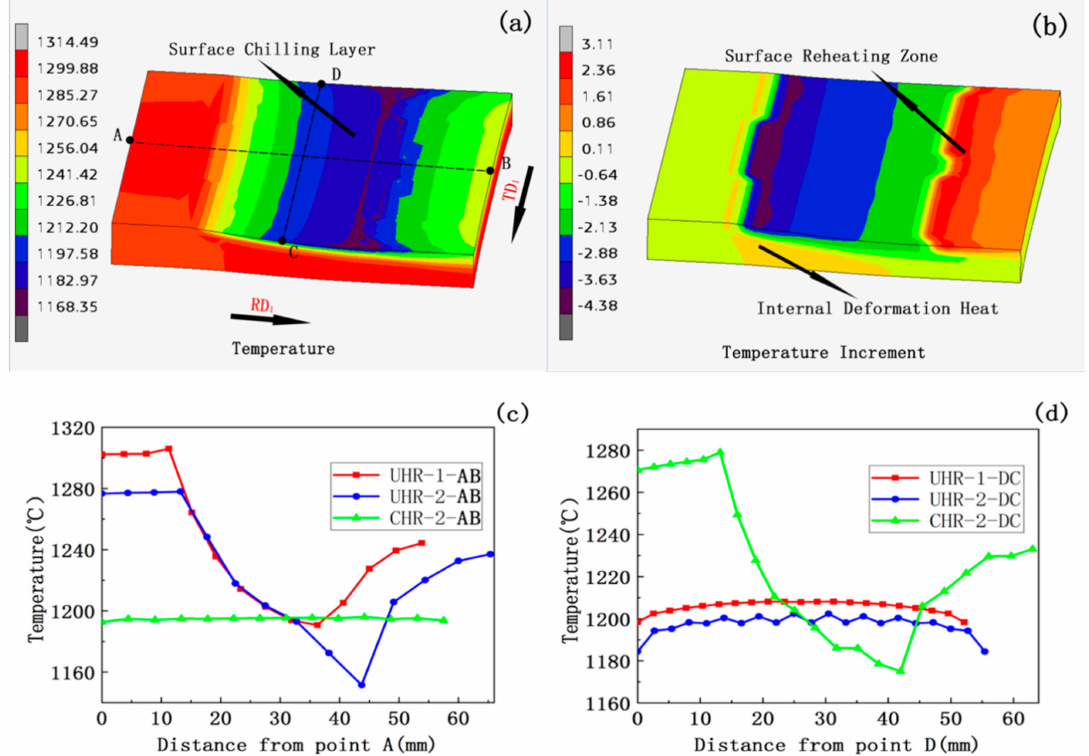
Figure 4. Temperature contours of rolling deformation zone: ( a ) temperature field of the first pass; ( b ) temperature increase profile (dT/dt) of the first pass; the temperature distributions of ( c ) and ( d ) are the AB and DC lines under the two rolling conditions,